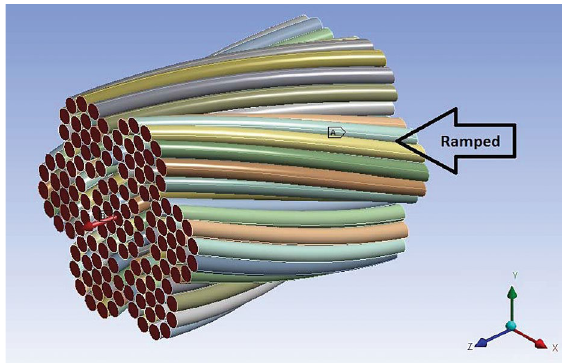
Fig. 12. Von Mises stresses for bonded contact settings – linear case solution for 1 × 19 wire rope core